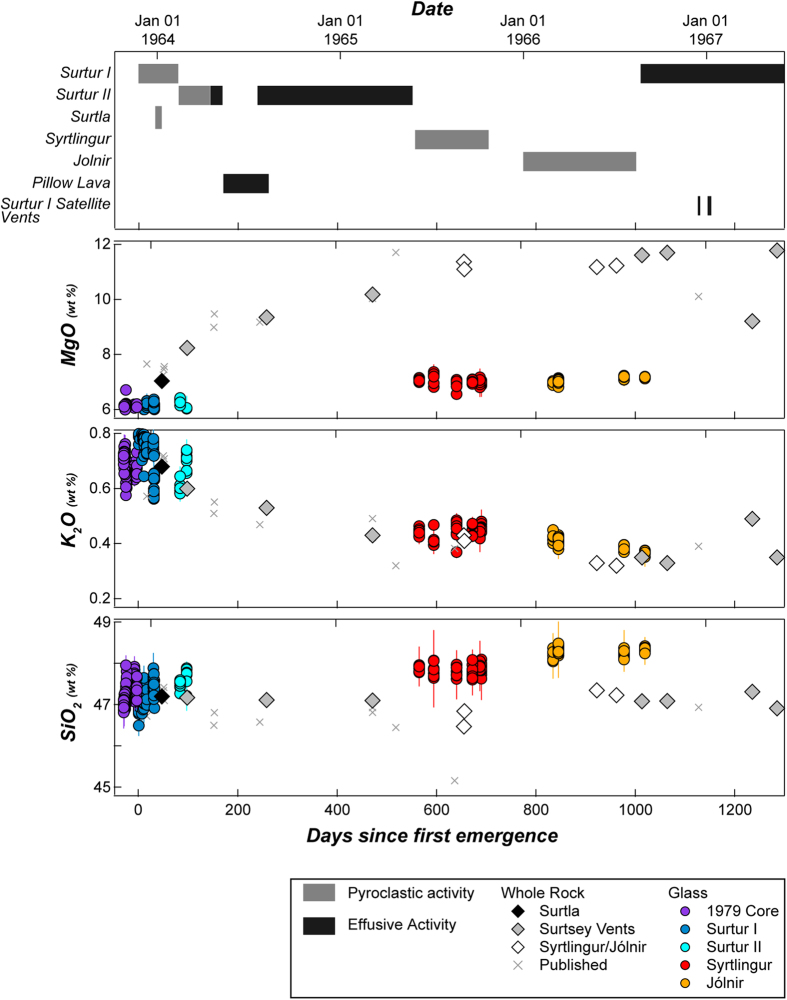
Time series of eruptive activity and overview of major-element variation.Grey crosses indicate previously published whole-rock analyses51322252831. Glasses plotted as individual grains (Table S2), the averages of which are listed in Tables 3, 4. Eruption day for drill core glasses are not known, but for plotting purposes are assumed to have accumulated at a constant rate over 1 month up to the November 14, 1963 emergence, and are plotted as negative days. Actual estimates of time from breaching the seafloor to emergence are much shorter15.